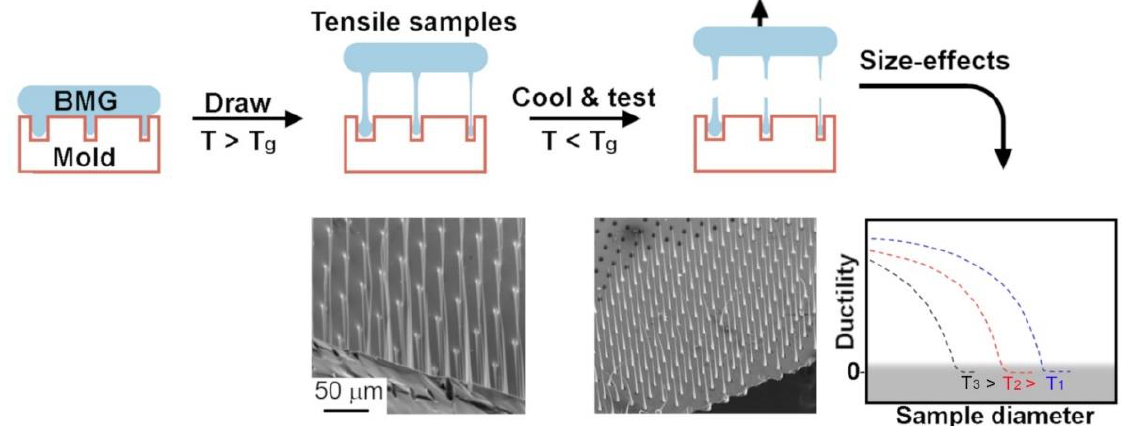
Figure 8. Application of thermoplastic drawing in characterization of size-effects in deformation of BMGs. Nanoscale tensile samples are formed by interrupting the drawing before rupture. The samples are cooled and fractured at different temperatures. Images show Pt-BMG nanoscale samples before and after fracture. The ductile-to-brittle transition shifted large to diameters with decreasing testing temperature.